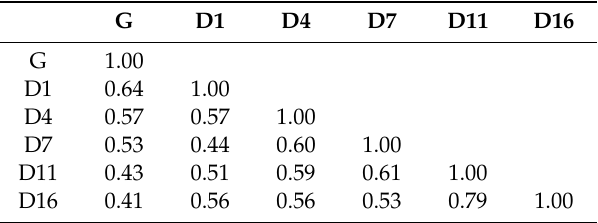
Table 2. Spearman correlation test reveals similarities between groups: G (grazing) group and D1, D4, D7, D11, and D16 (feedlot feeding days 1, 4, 7, 11, and 16, respectively). G D1 D4